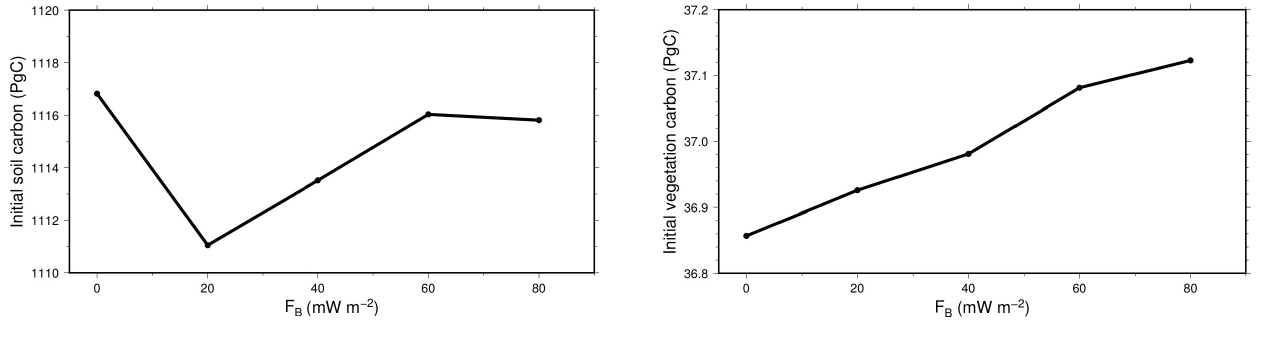
Figure 17. Mean initial size (1901–1910) of the vegetation carbon pool in the Northern Hemisphere permafrost region, in function of bottom heat